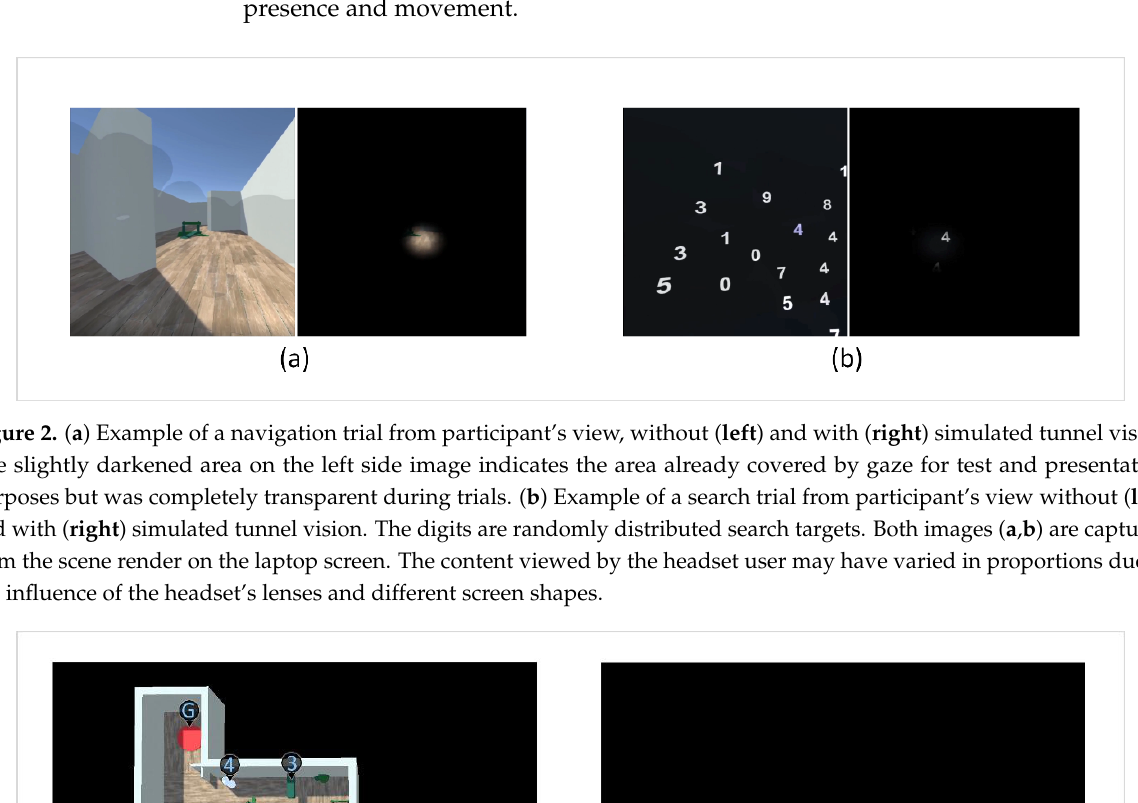
Figure 2. ( a ) Example of a navigation trial from participant’s view, without ( left ) and with ( right ) simulated tunnel vision. The slightly darkened area on the left side image indicates the area already covered by gaze for test and presentation purposes but was completely transparent during trials. ( b ) Example of a search trial from participant’s view without ( left ) and with ( right ) simulated tunnel vision. The digits are randomly distributed search targets. Both images ( a , b ) are cap- tured from the scene render on the laptop screen. The content viewed by the headset user may have varied in proportions due to the influence of the headset’s lenses and different screen shapes.